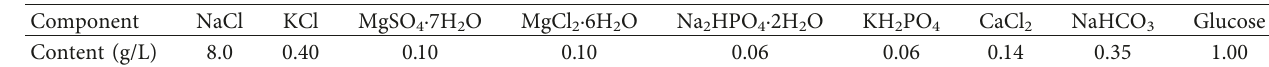
Table 3: The composition of Hank’s balanced salt solutions (g/L).